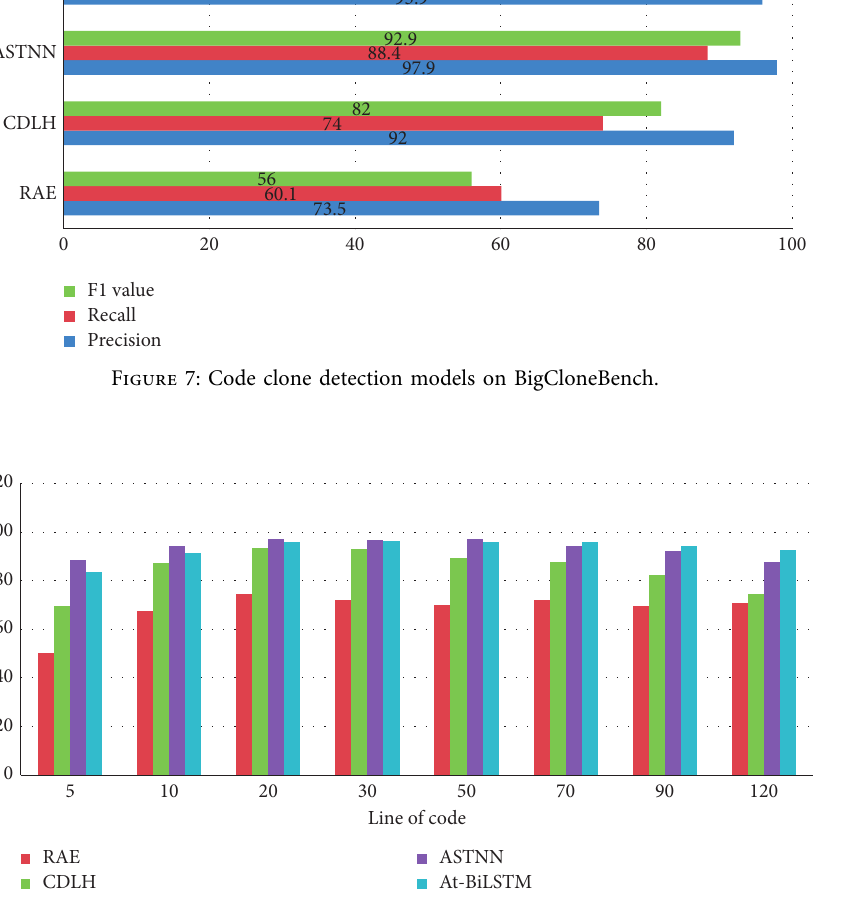
Figure 8: Precision of code clone detection models according to